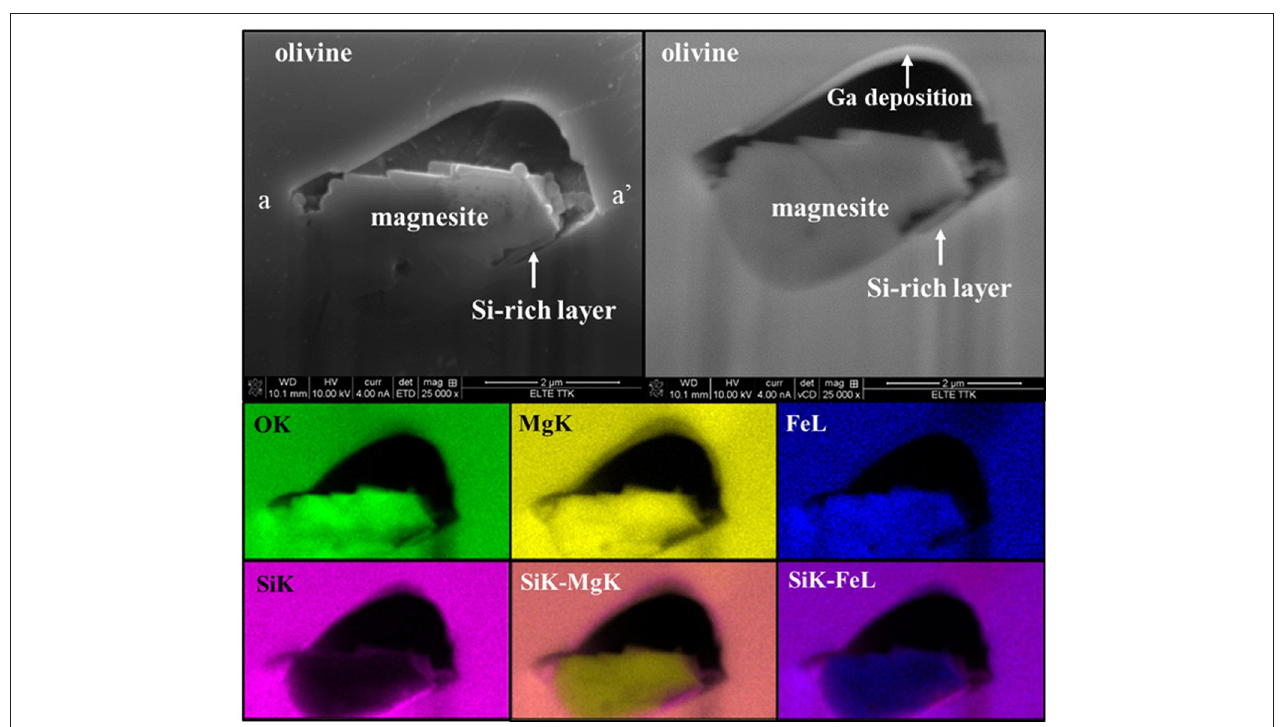
FIGURE 6 | SE (top left) and BSE (top right) images and EDS X-rays element distribution maps for O, Si, Mg and Fe and Si-Mg and Si-Fe composite element distribution maps. The deposition of gallium from the focused gallium ion beam used to slice the fluid inclusion is shown on the BSE image. The images were taken along the a-a’ cross section of the fluid inclusion shown on Figure 5 . Element distributions support the identification of phases based on Raman analyses. A Si-rich layer of ∼ 100nm maximum thickness can be observed in the bottom right corner of the inclusion. The spherical objects on the surface of the magnesite crystals with a uniform diameter of ∼ 200nm are most likely amorphous silica spheres precipitated as a result of opening the fluid inclusion and evaporation of the aqueous phase containing some dissolved silica. Magnesite contains Fe. TABLE 3 | The effect of inclusion size and shape on calculated reaction rates ( r , mol/s) and fluxes ( J , mol/m 2 s).